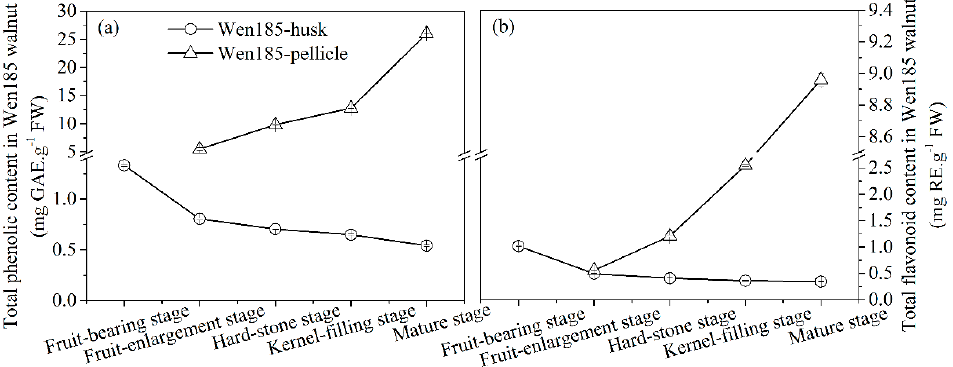
Figure 1. Changes of total phenol ( a ) and flavonoid ( b ) contents of walnut husk and pellicle.